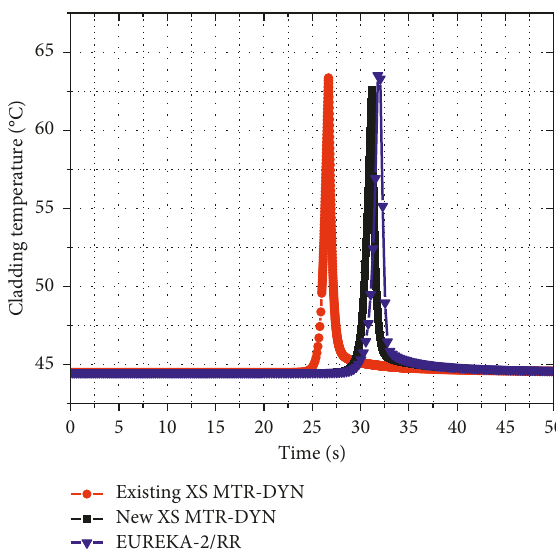
Figure 11: Cladding temperature during RIA transient at initial power